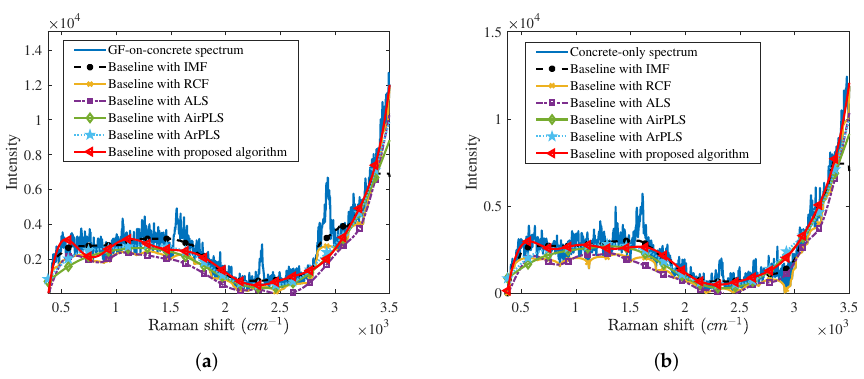
Figure 4. Baselines estimated by several baseline correction algorithms from ( a ) the GF-on-concrete spectrum and ( b ) the concrete-only spectrum.